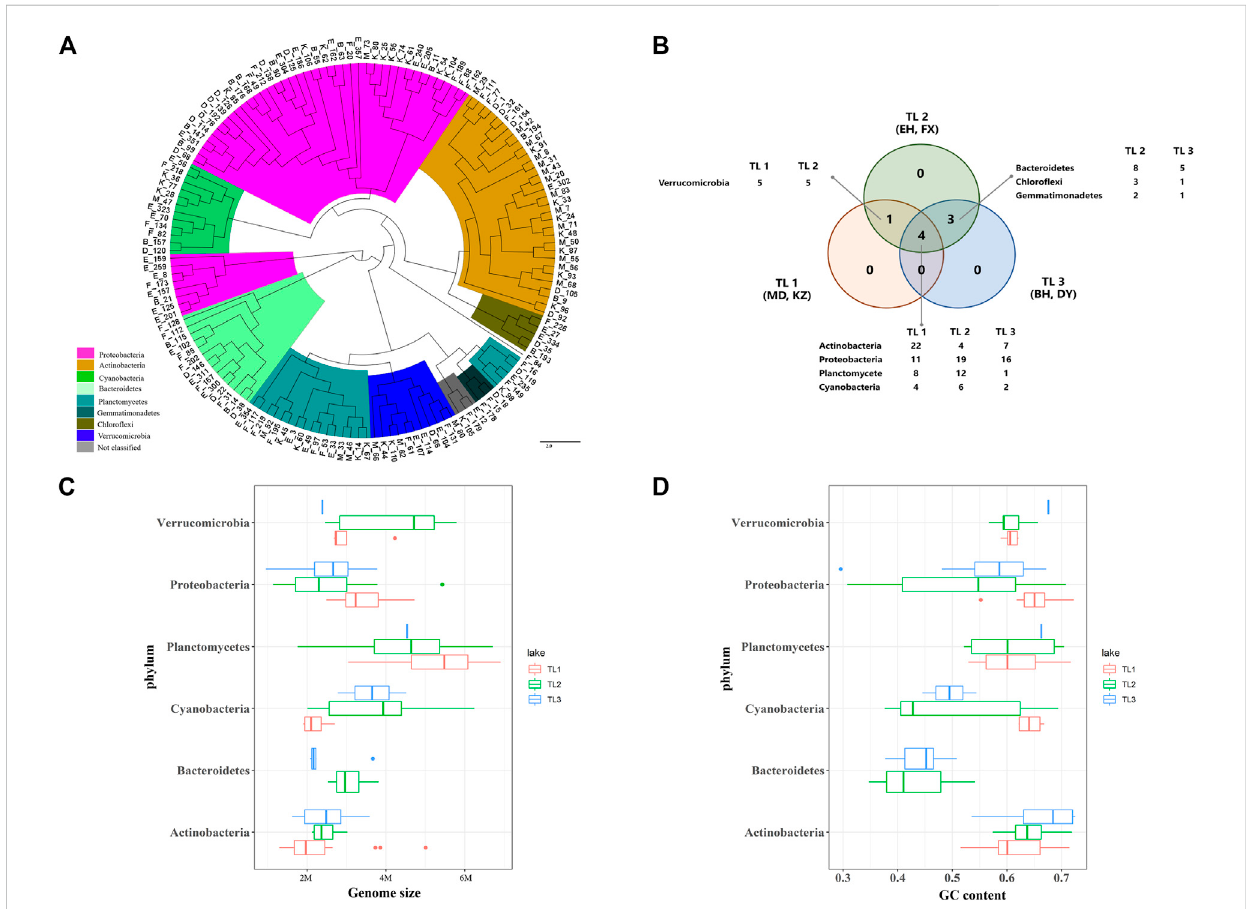
FIGURE 3 High-quality genomic characterization. (A) Whole-genome phylogenetic tree. Different colors represent different phyla. (B) Venn diagram of the distributionofspeciesbasedonMAGs,thenumberafterspeciesisthecountofMAG. (C) Groupingboxdiagramoftherelationshipbetweengenomesize and phylum. (D) Grouping box diagram of the relationship between GC content and